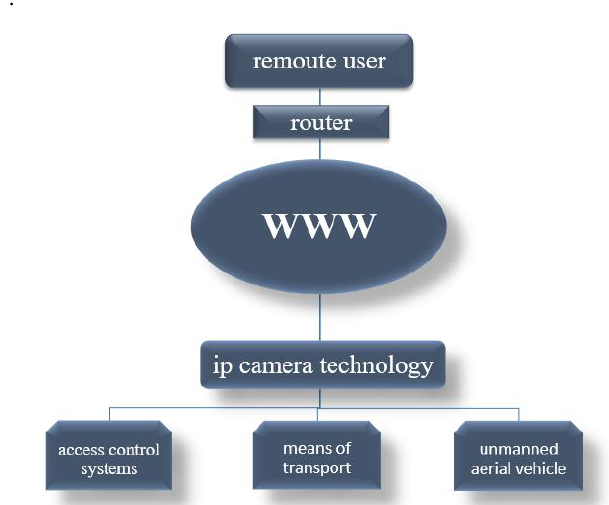
Fig. 1. An example of cloud technology structure The 3D identification function, including 3D scanning, will allow you to simulate the probed sector in order to make it more responsive for further analytical work and action planning. technologies-identification, given the possible implementation of all kinds of threats come to the fore in effective problem-solving search and identification (including the simulation objects).